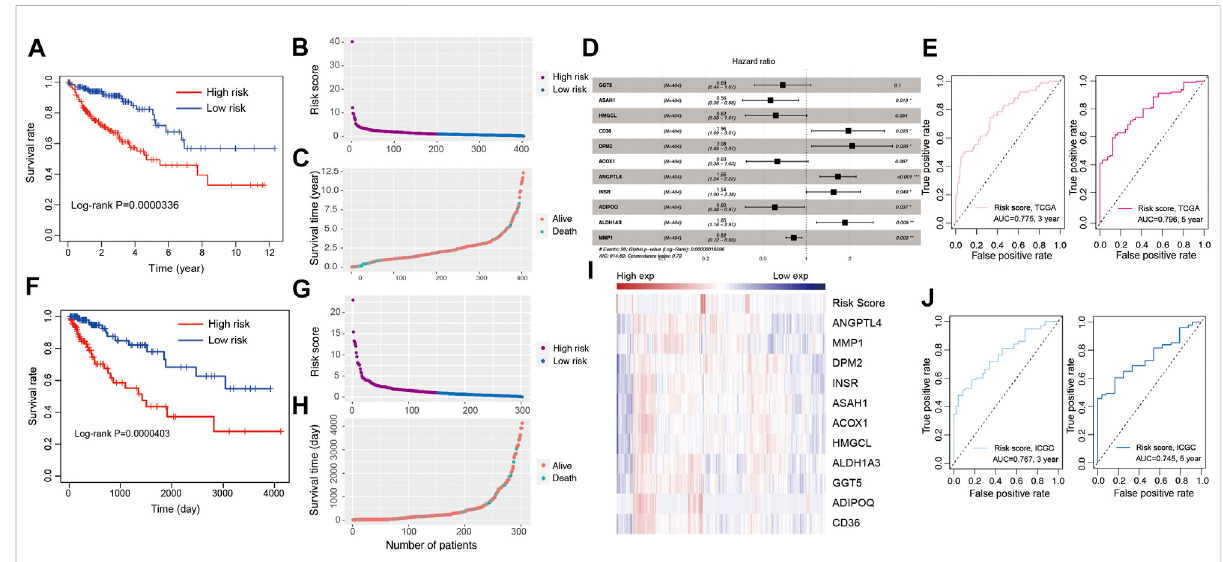
FIGURE 3 Development of risk model based on the 11 LMGs signature of CRC patients with the TCGA training cohort and ICGC validation database. (A) Kaplan-Meier survival plot for overall survival based on risk score of LMGs signature in TCGA cohort. (B) Risk score of CRC patients in high- and low risk groups in TCGA cohort. (C) Distribution of time under survival curve and survival status of each patient in TCGA cohort. (D) Multivariate Cox regression analysis of LMGs signature characteristics TCGA cohort. (E) ROC curve for 3 and 5 years overall survival TCGA cohort. (F) Kaplan- Meier survival plot showing overall survival using risk score of LMGs signature in ICGC validation database. (G) Risk score of CRC patients in risk groups in ICGC validation database. (H) Distribution of survival time and survival status of each patient in ICGC validation database. (I) The heatmap showingthegeneexpressionof11LMGssignatureandriskscoreinICGCvalidationdatabase. (J) ROCcurvefor3and5 yearsoverallsurvivalinICGC validation database. LMGs: Lipid metabolism-associated